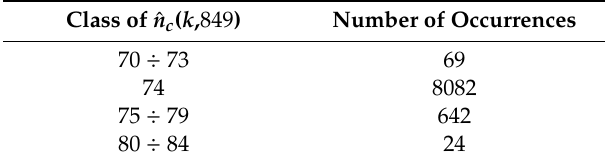
Table 10. Distribution of the number of overloaded lines in N − 1 condition at hour